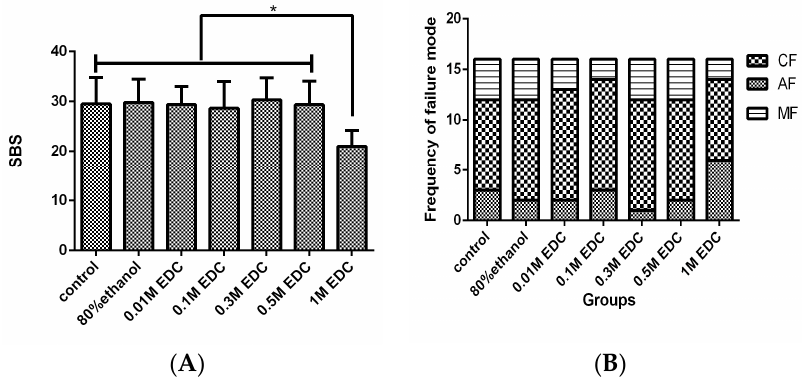
Figure 1. ( A ) The dentin shear bond strength with Single Bond 2 for different surface treatments. The asterisk indicates a significant difference in SBS between pretreatments (Tukey’s test, p < 0.001). The dentin bond strength of the 1.0 M EDC group was distinctly lower than the corresponding data that was obtained for the other surface treatment groups; ( B ) The failure mode frequency of the SBS test for different treatment groups, where no significant difference was found. * indicates significant difference compared with 1.0 M EDC group ( P < 0.05).